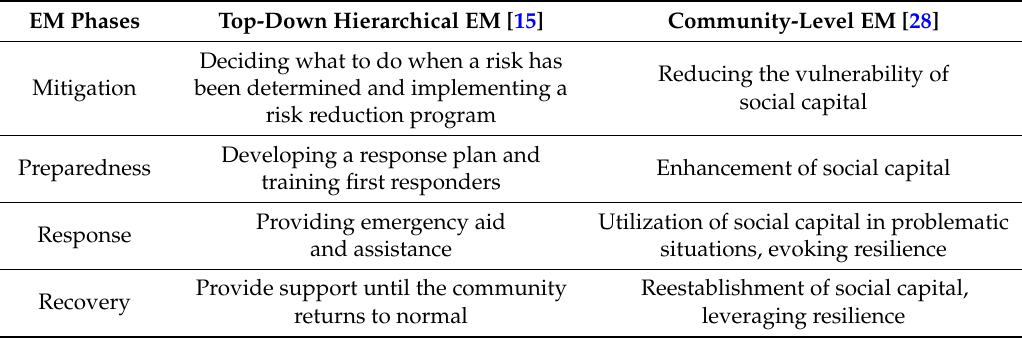
Table 1. Different perspectives of the EM (emergency management)